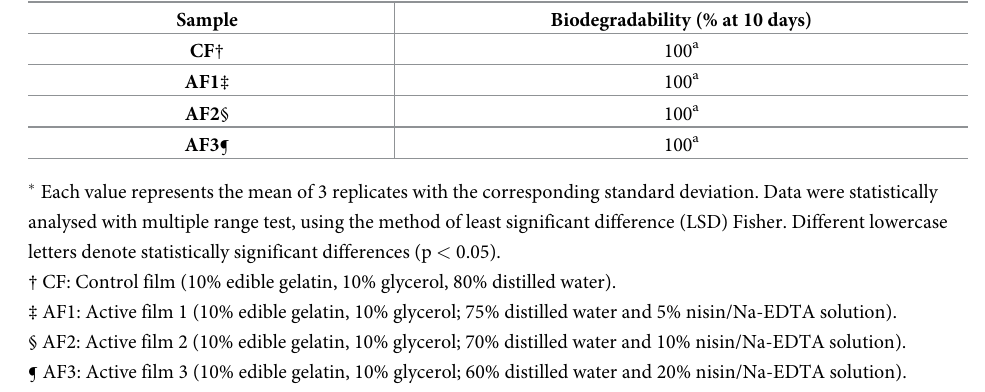
Table 4. Evaluation of the biodegradability percentage of the films. � Sample